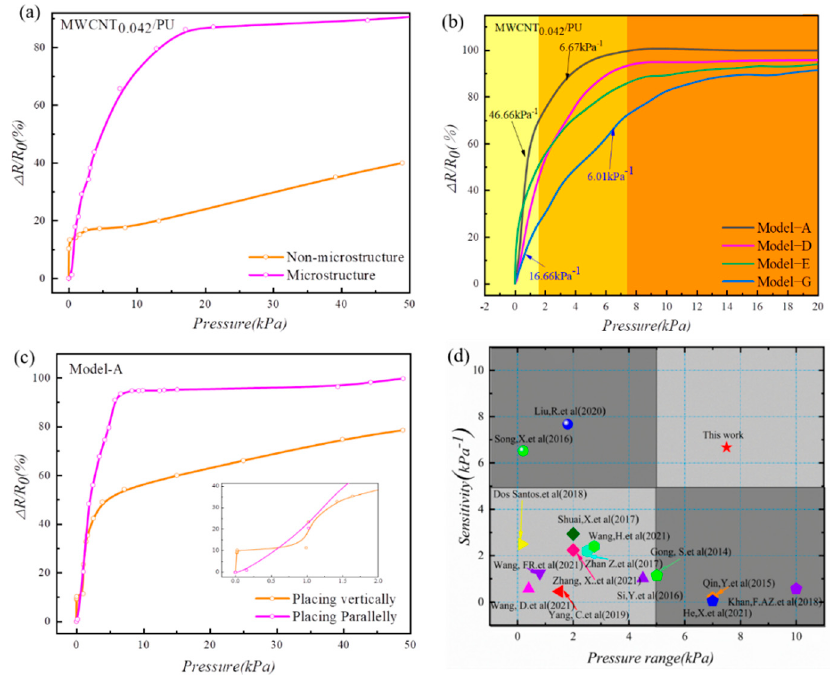
Figure 9. Sensing performance of the presented sensors. ( a ) Pressure-response of the sensor with and without microstructures. ( b ) Pressure-responses of MCNF sensors with the same MWCNT con-tents and different microstructures. ( c ) Pressure-response of MCNF sensor placed vertically and parallel to electrodes. ( d ) Comparison of the sensitivities and operating ranges in the literature and our work.